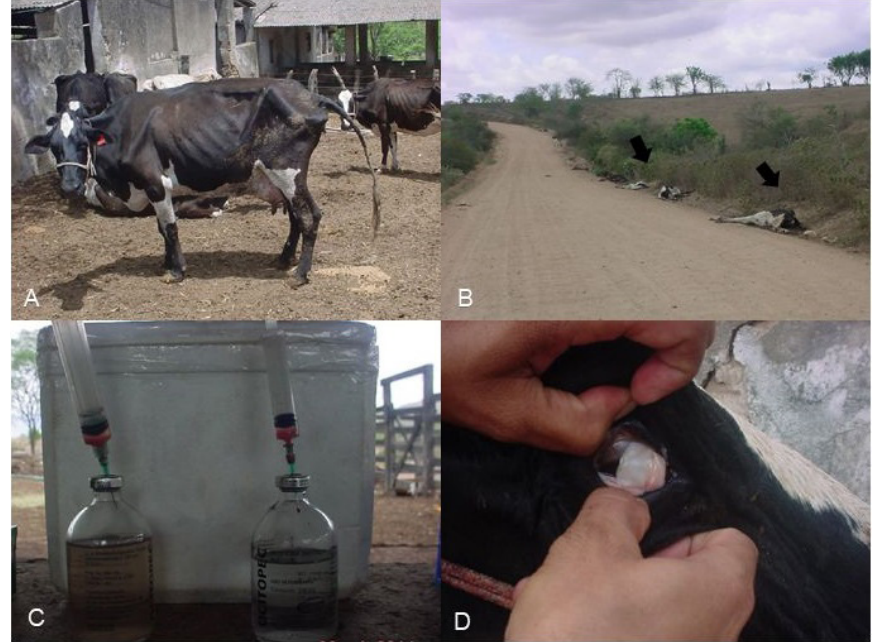
Figure 1. Animals affected by Trypanosoma vivax . (A) Animal presented weight loss and diarrhea. (B) High mortality of animals (arrows). (C) Use of oxytocin with sharing of needle and syringe, contaminated by blood. (D) Animal with pale ocular